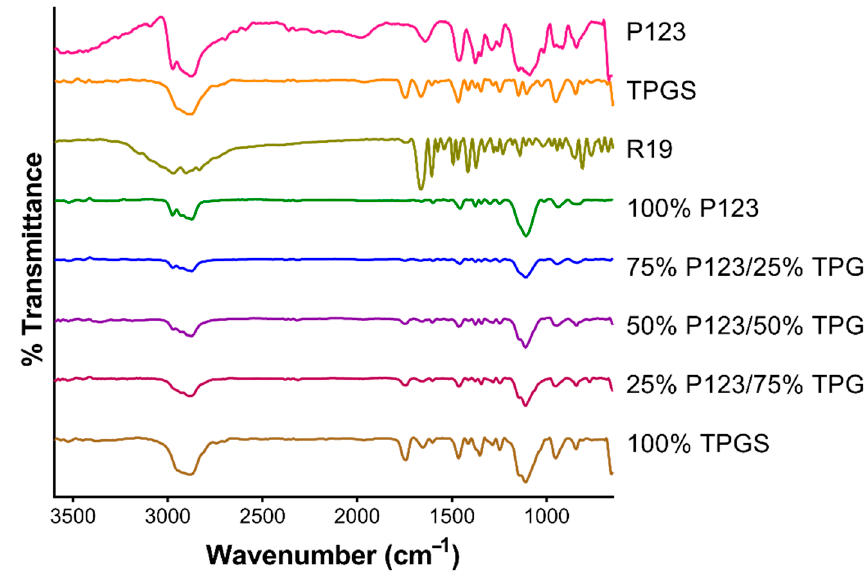
Figure 4. FTIR spectra of R19, P123, TPGS, and R19-loaded NPs.